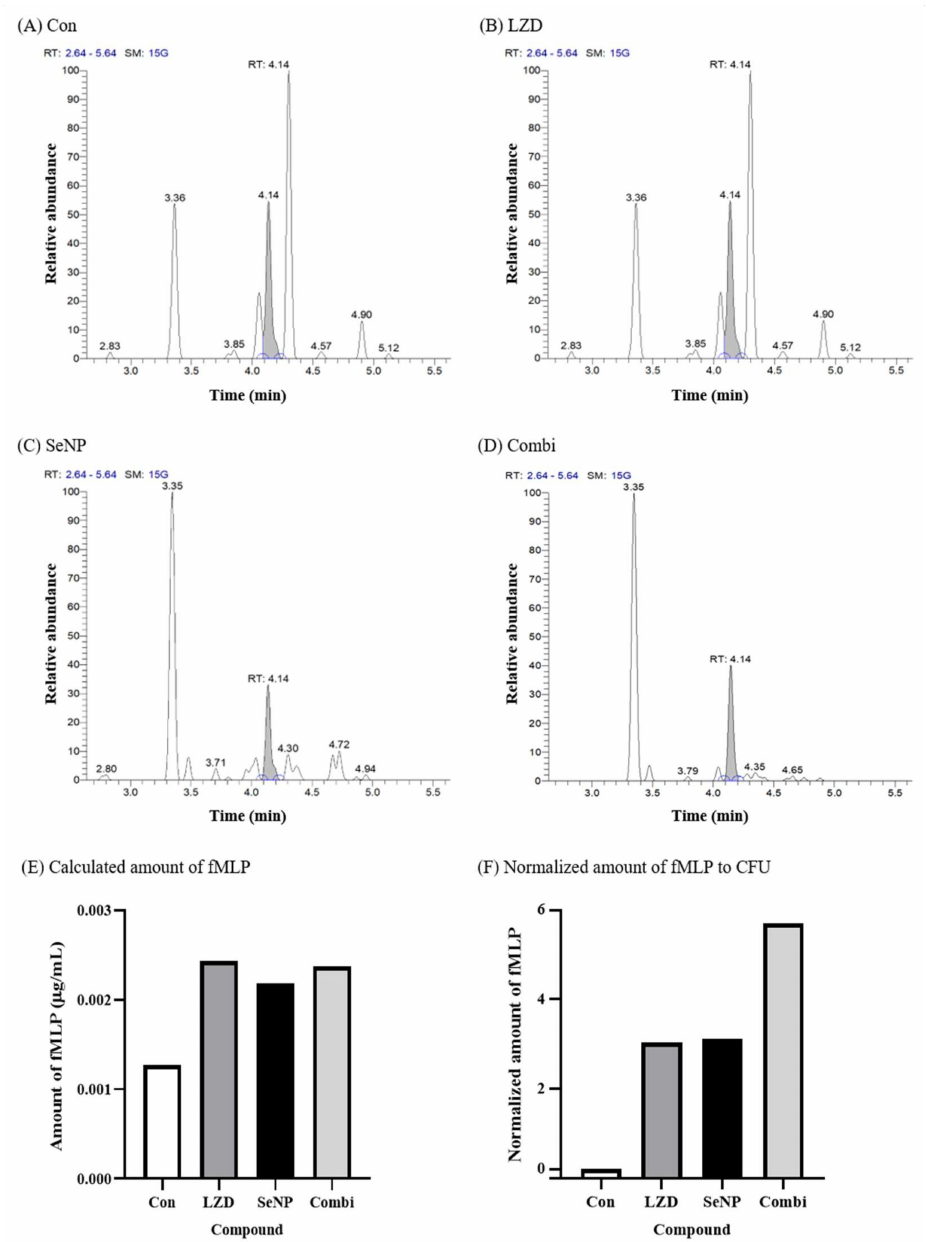
Figure 5. fMLP quantification by LC-MS/MS for the protein degradation test against MRSA 700699. ( A ) Control (without any antimicrobial agents), ( B ) LZD, ( C ) SeNP, ( D ) Combination (LZD + SeNP), ( E ) calculated amount of fMLP, and ( F ) normalized amount of fMLP to CFU. A protein degradation test was performed with only MRSA 700699, which showed the greatest synergistic effect in Figure 4. The CFU values used in ( B ) are shown in Figure 4B. The control was a bacterial solution without any antimicrobial agents. The concentrations of LZD and SeNP were the same as those used in Figure 4. In ( F ), as expected, the control group showed the lowest protein degradation value, and the combi group showed more protein degradation per bacterium than the single administration groups. Therefore, it seems that LZD and SeNPs showed synergistic effects through protein